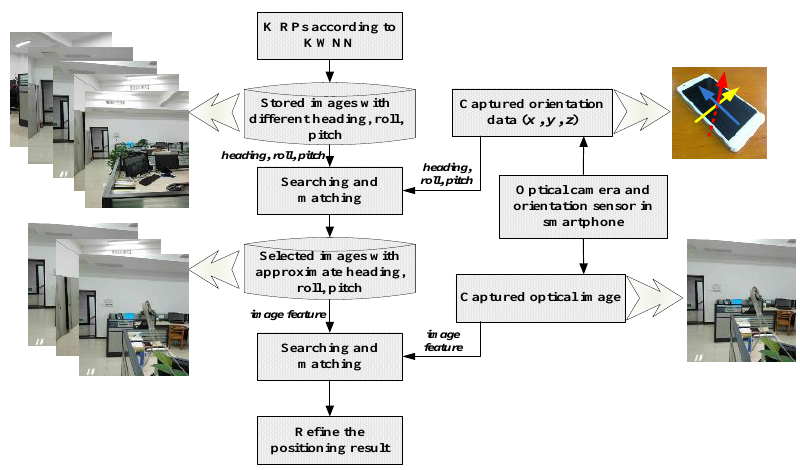
Figure 1. Framework of positioning calibration using built-in sensors in a smartphone.